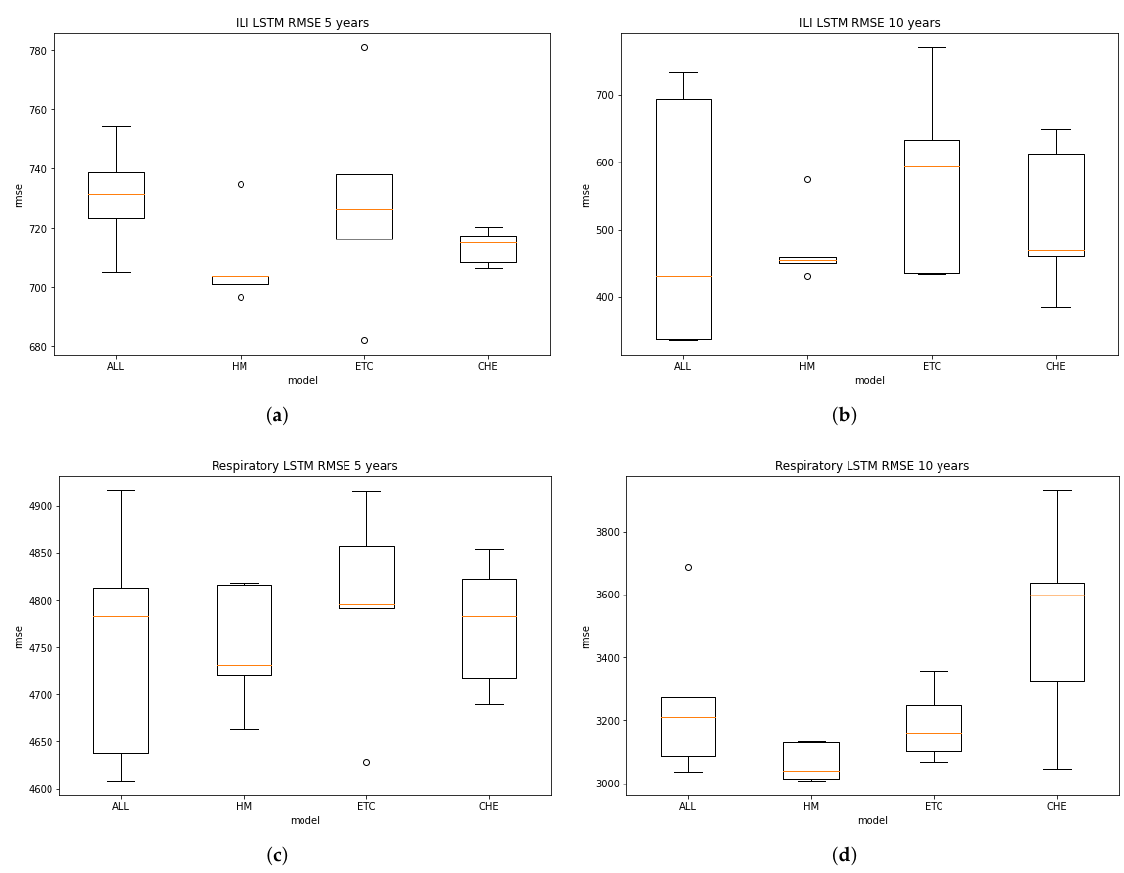
Figure 6. The bloxplot prediction distribution in 5 times repetitions. ( a ) ILI LSTM boxplot from 5 years dataset training; ( b ) ILI LSTM boxplot from 10 years dataset training; ( c ) Respiratory LSTM boxplot from 5 years dataset training; ( d ) Respiratory LSTM boxplot from 10 years dataset